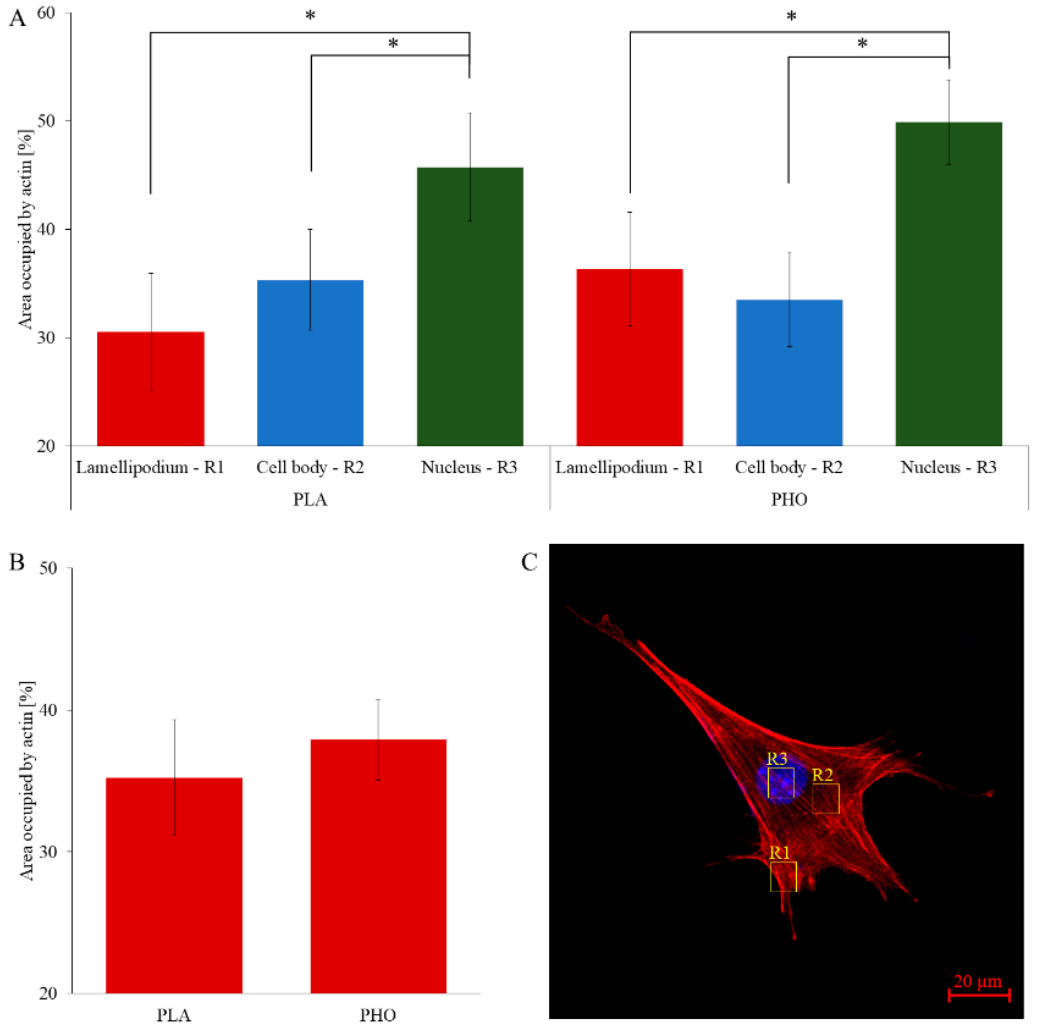
Figure 5. Comparison of area occupied by actin divided into individual cell regions and substrates ( A ), compared with the area occupied in the whole cell ( B ). Exemplary regions taken into consideration during the analyses are depicted in panel ( C ): R1—lamellipodium, R2—nucleus, R3—cell body. In total 35 cells for PLA and 40 cells for PHO have been examined. Data for PHO sourced from [21]. Results statistical significance: * p < 0.05